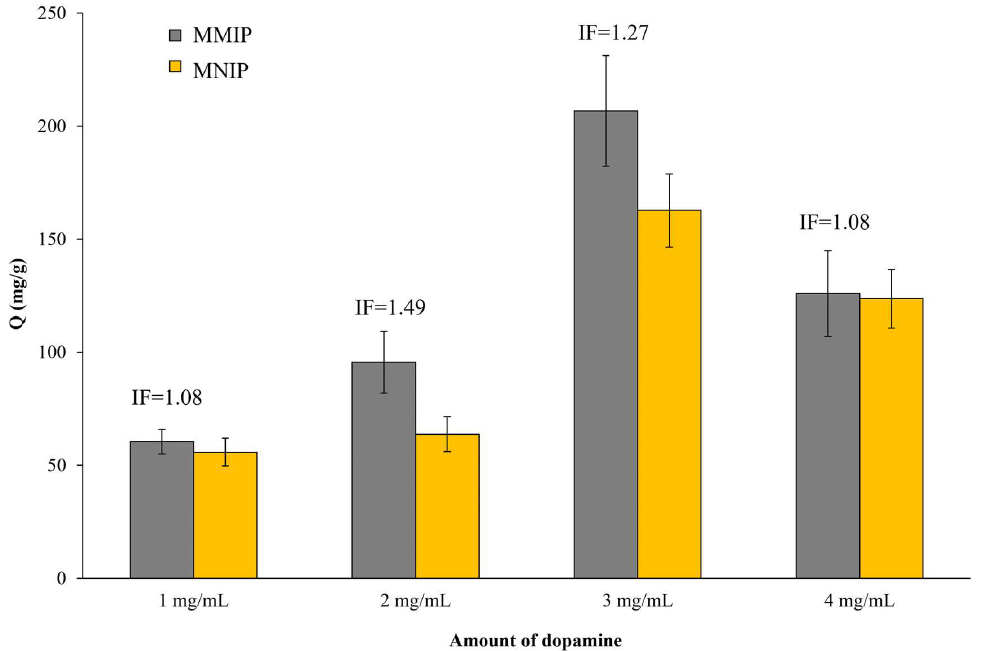
Figure 4. Evaluation of the binding capacities and IFs of MMIPs/MNIPs prepared with different amounts of dopamine.